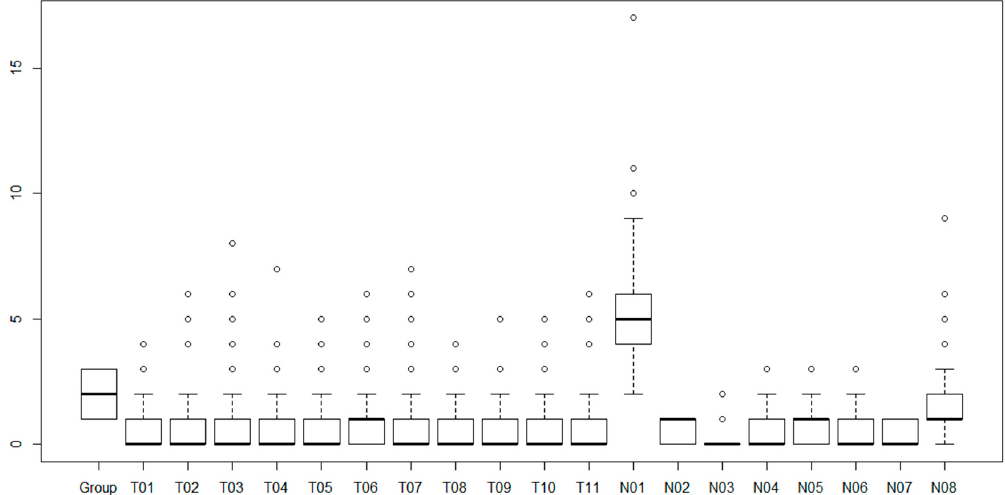
Figure 6. Integrated variables distribution.